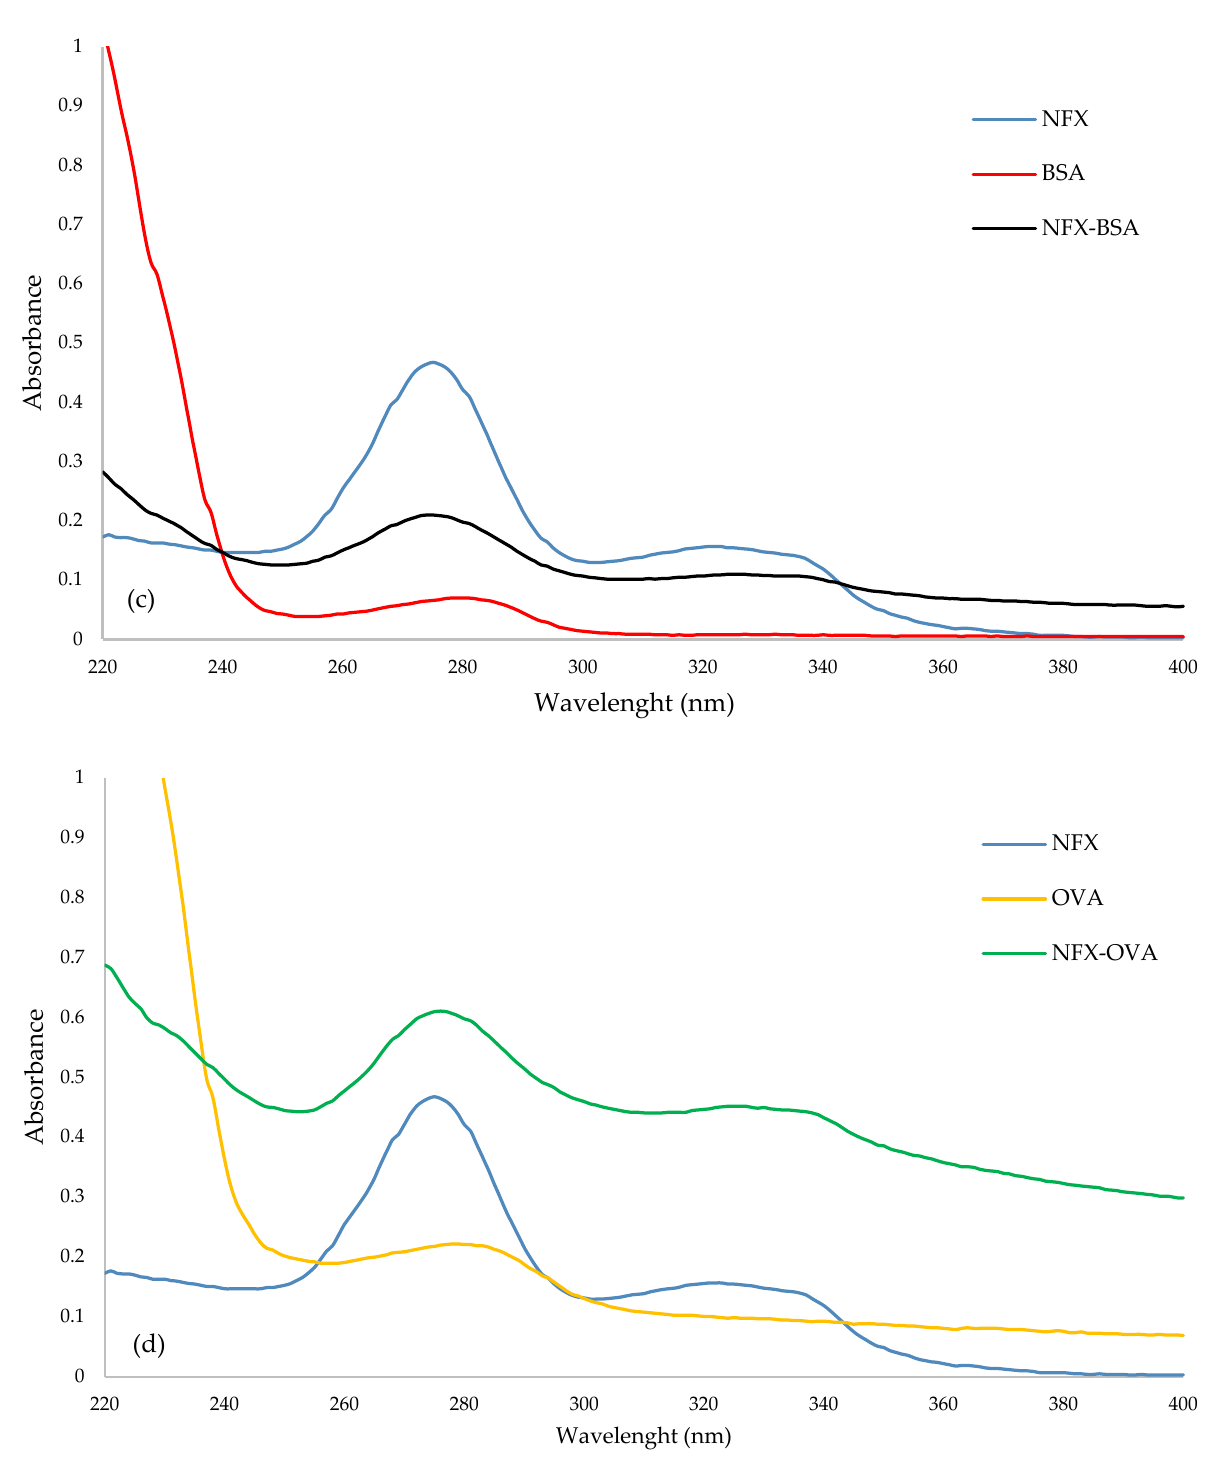
Figure 1. The UV–visible absorption spectra of immunogen and the coating antigen was character- ized by spectrophotometry: ( a ) spectrum of CPFX, BSA, and immunogen conjugates (CPFX-BSA); ( b ) spectrum of CPFX, OVA, and the coating antigen (CPFX-OVA); ( c ) spectrum of NFX, BSA, and immunogen conjugates (NFX-BSA); ( d ) spectrum of NFX, OVA, and the coating antigen (NFX- OVA).